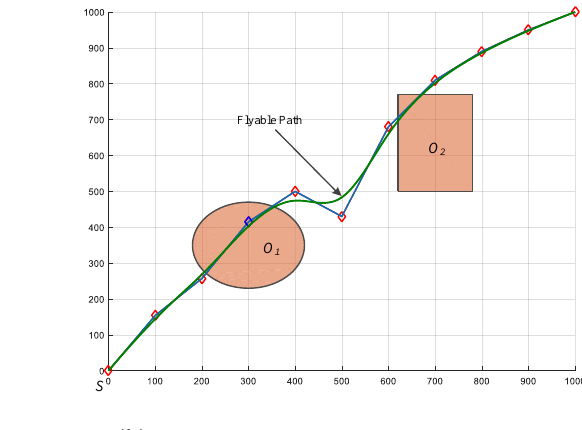
( b ) Flyable path developed from the control points. Figure 1. General model and flyable path for two-dimensional UAV path